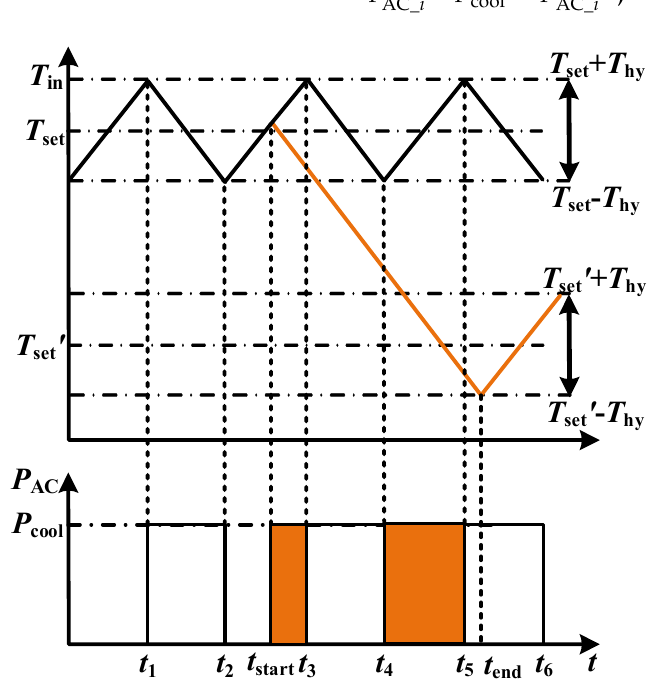
Figure 3. The operating performances of the AC for over-voltage. When the distribution network encounters an under-voltage problem, the AC increases the set temperature; the operating performance of the AC is illustrated in Figure 4. The variation curves of the room temperature and the AC’s operating power are shown in Figure 4. The orange curve and orange parts illustrate the room temperature and decrease in the operating power after the AC participates in the under-voltage regulation. When the smart controller receives the under-voltage regulation signal at the time t start , the set temperature increases from T set to T set (cid:48) . During t start – t end , the compressor keeps the standby state, which results in a decrease in operating power. In this way, the AC